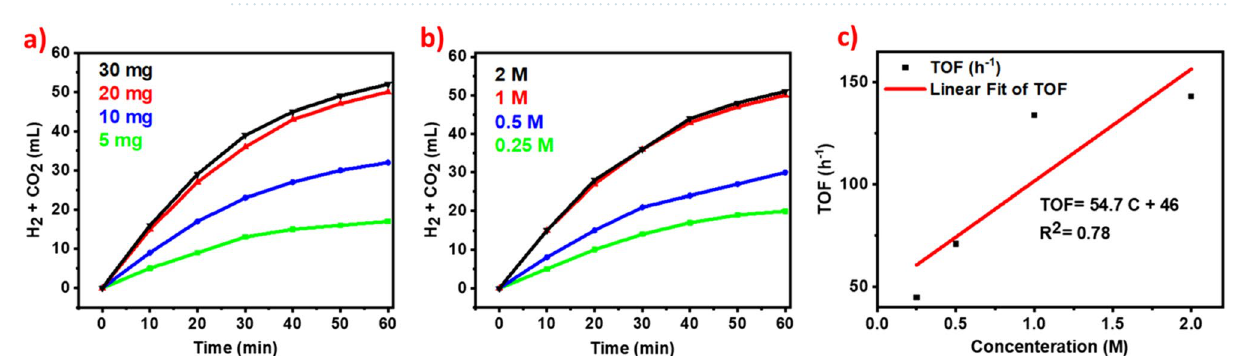
Figure 9. ( a ) The volume of gas evolution in the use of different amount of Ag 1 Pd 1 /SLCN for the photo- decomposition of FA, ( b ) the volume of gas evolution in the use of different concentrations for the photocatalytic decomposition of FA and ( c ) Initial TOF versus concentrations for Ag 1 Pd 1 /SLCN under light irradiation.